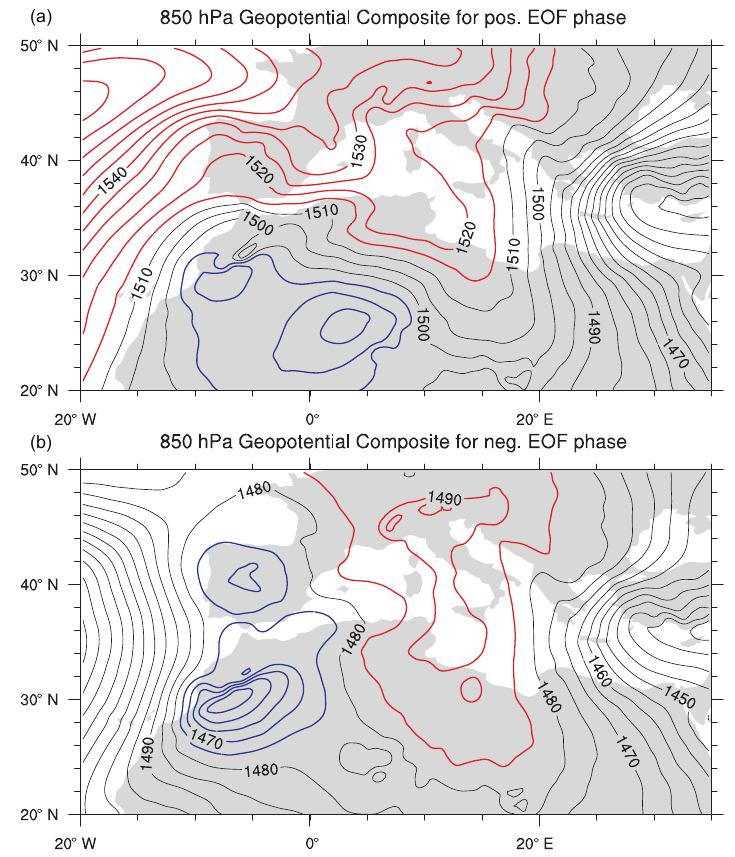
Figure 5. Composite of the 850hPa geopotential height (gpm) for positive (a) and negative (b) phases of the first EOF from June to July 2013.